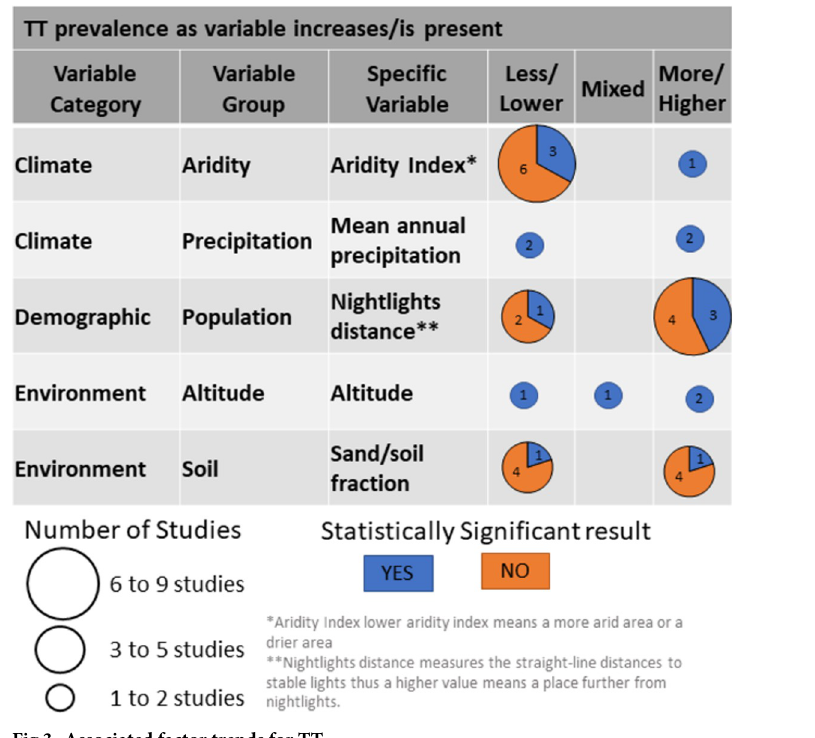
Fig 3. Associated factor trends for